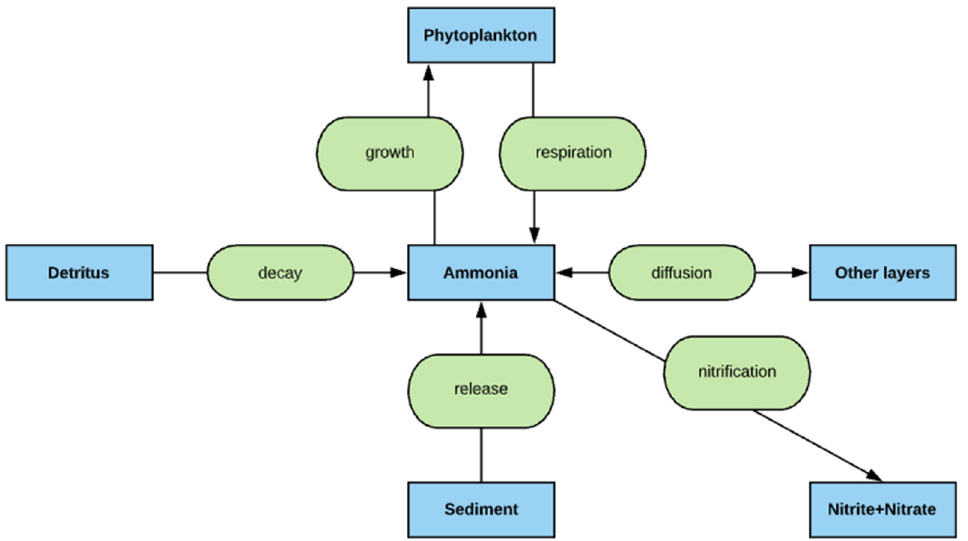
Figure 4. Schematic diagram of ammonia cycle modeled by MINLAKE2020.